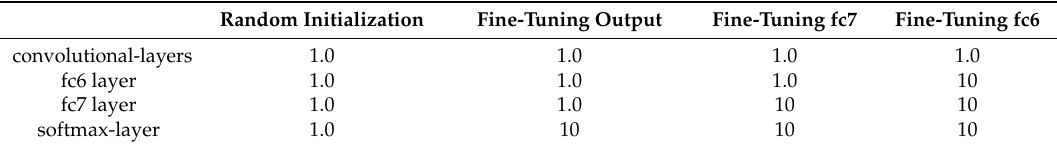
Table 2. Multiplicative factors of different